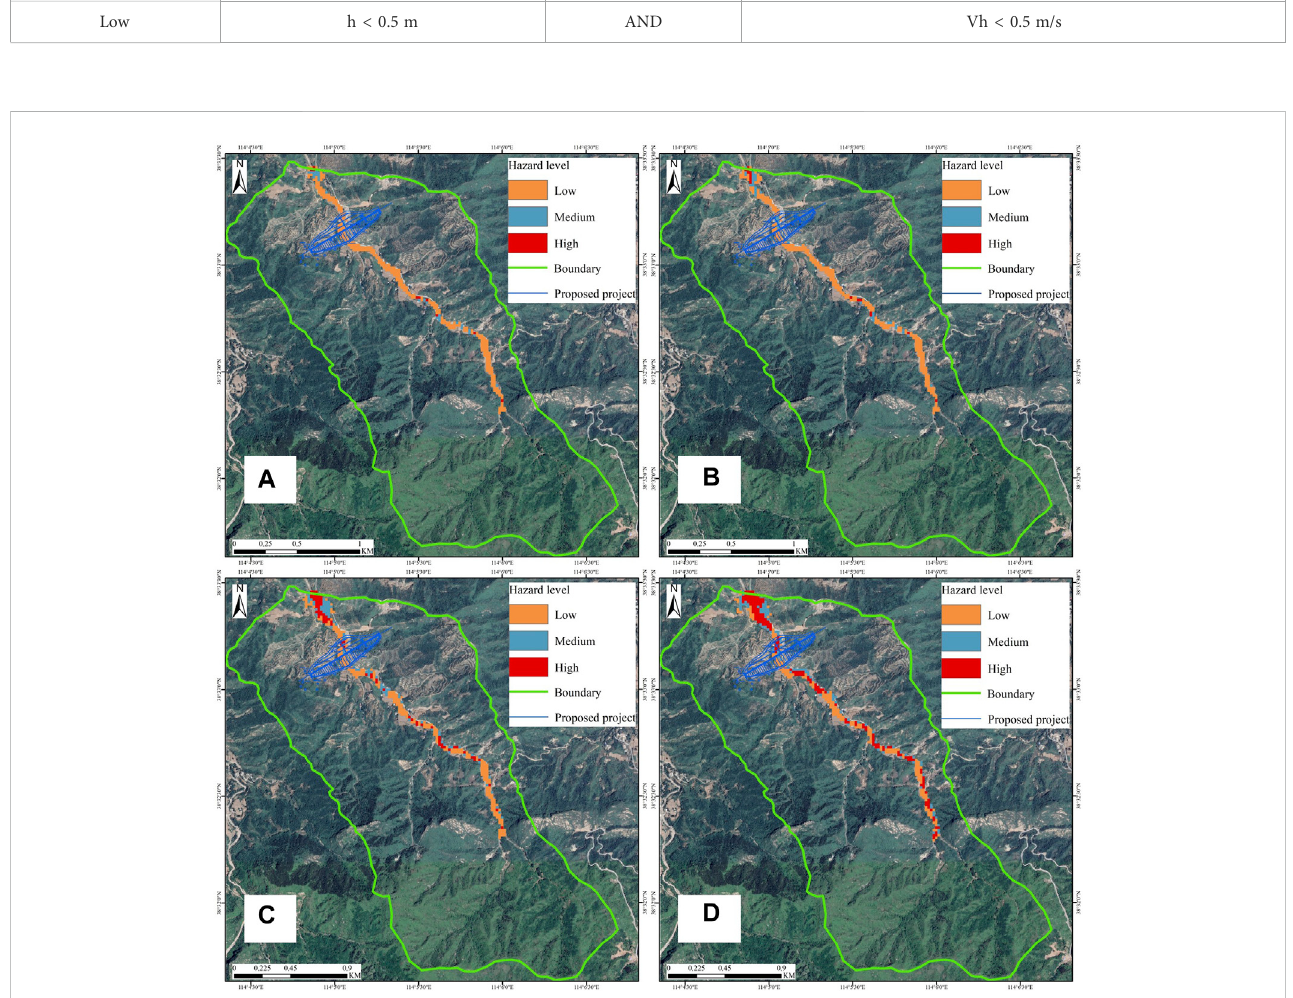
FIGURE 6 Hazard zonation of debris fl ow at various rainfall frequencies. (A) (a)Hazard zonation under 10-year rainfall, (B) (b)Hazard zonation under 20-year rainfall, (C) (c)Hazard zonation under 50-year rainfall, (D) (d)Hazard zonation under 100-year rainfall.